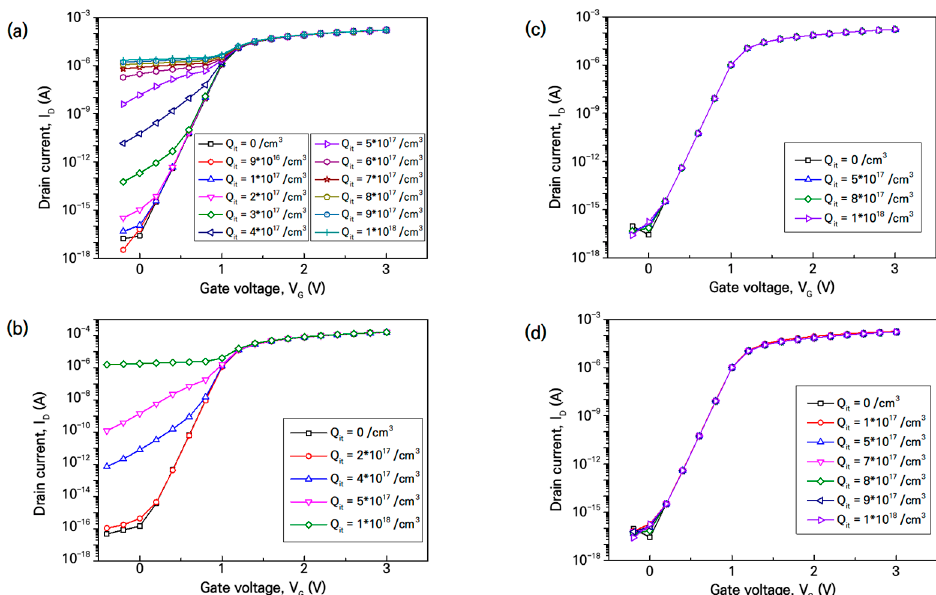
Figure 4. Radiation damage models when radiation-induced interface charges were injected into ( a ) the standard structure; ( b ) the extended gate poly structure; ( c ) the structure to which the p- active and p+ doping regions are added; and ( d ) the combined structure of ( b , c ).